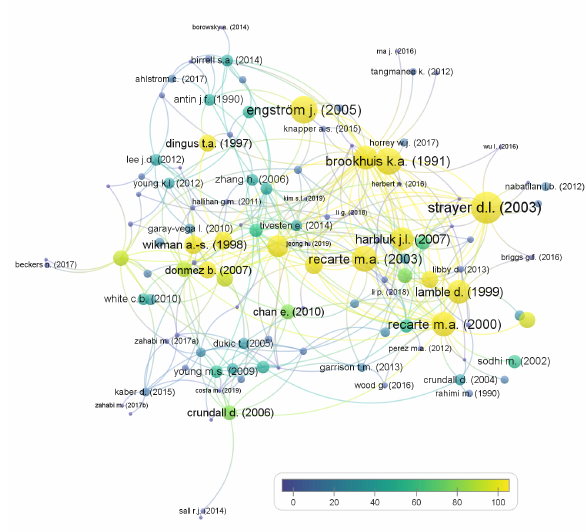
Figure 3. Citation